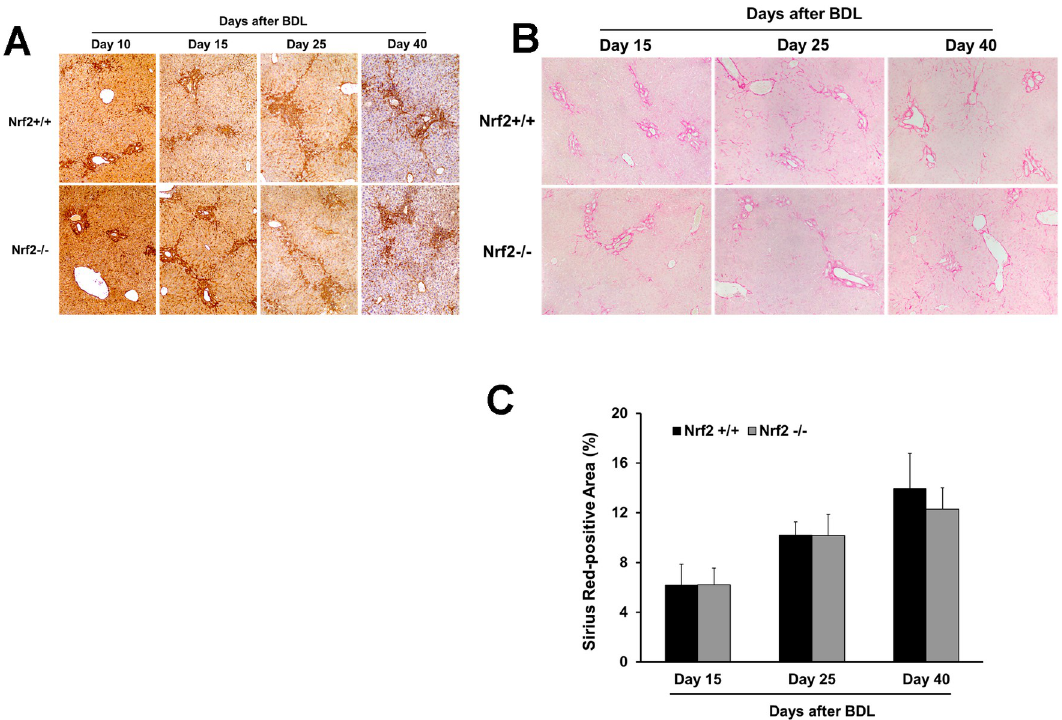
Fig 5. Hepatic fibrotic response to bile duct ligation (BDL) in Nrf2 +/+ and Nrf2 -/- mice. The liver sections from the livers of mice after BDL underwent laminin immunostaining or Sirius Red staining. (A) Representative liver sections with laminin immunostaining. The septal tissue rich in laminin was stained prominently dark brown. (B) Representative liver sections with Sirius Red staining. (C) Sirius Red staining areas were quantified using Image-Pro Plus software at 200x magnification in 5 randomly chosen fields per section. The results are shown as the means of percentages ± SD (n =